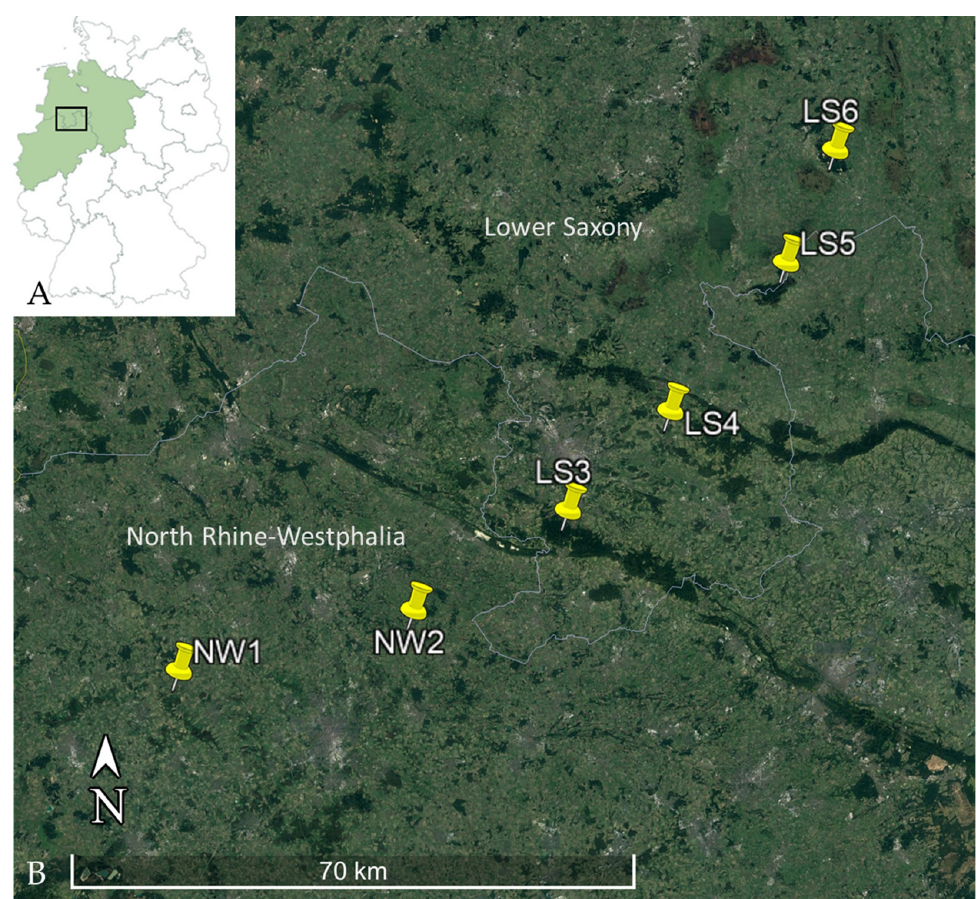
Figure 1. ( A ) Map of Germany with involved federal states highlighted in green and location of the transect marked by a square, ( B ) Trapping locations within the transect, NW = North Rhine-Westphalia, LS = Lower Saxony. Image was created by using Google Earth Pro, Map: Google Earth ©2021 Google, Image Landsat/Copernicus ©2021 GeoBasis-DE/BKG.